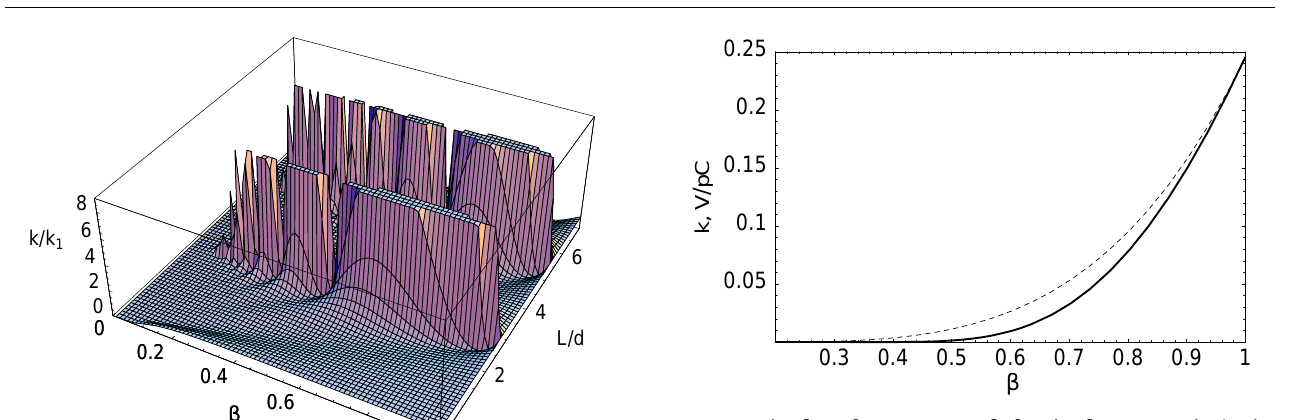
FIG. 2. The loss factor versus b for the lowest mode in the pill-box cavity. The dashed line shows the dependence (13) for a small